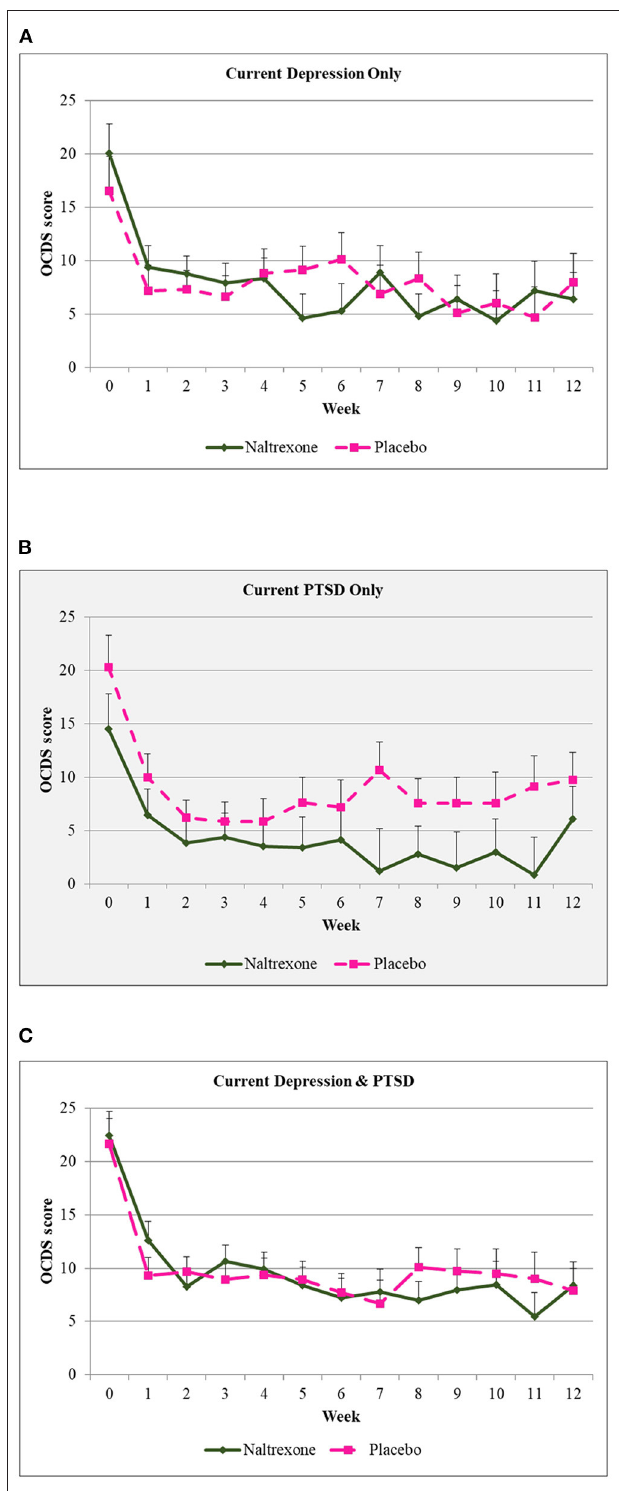
FIGURE 3 | Obsessive Compulsive Drinking Scale scores over time by diagnostic group. (A) Craving scores over 12 weeks of treatment for those diagnosed with depression only who were given either naltrexone or placebo. (B) Craving scores over 12 weeks of treatment for those diagnosed with